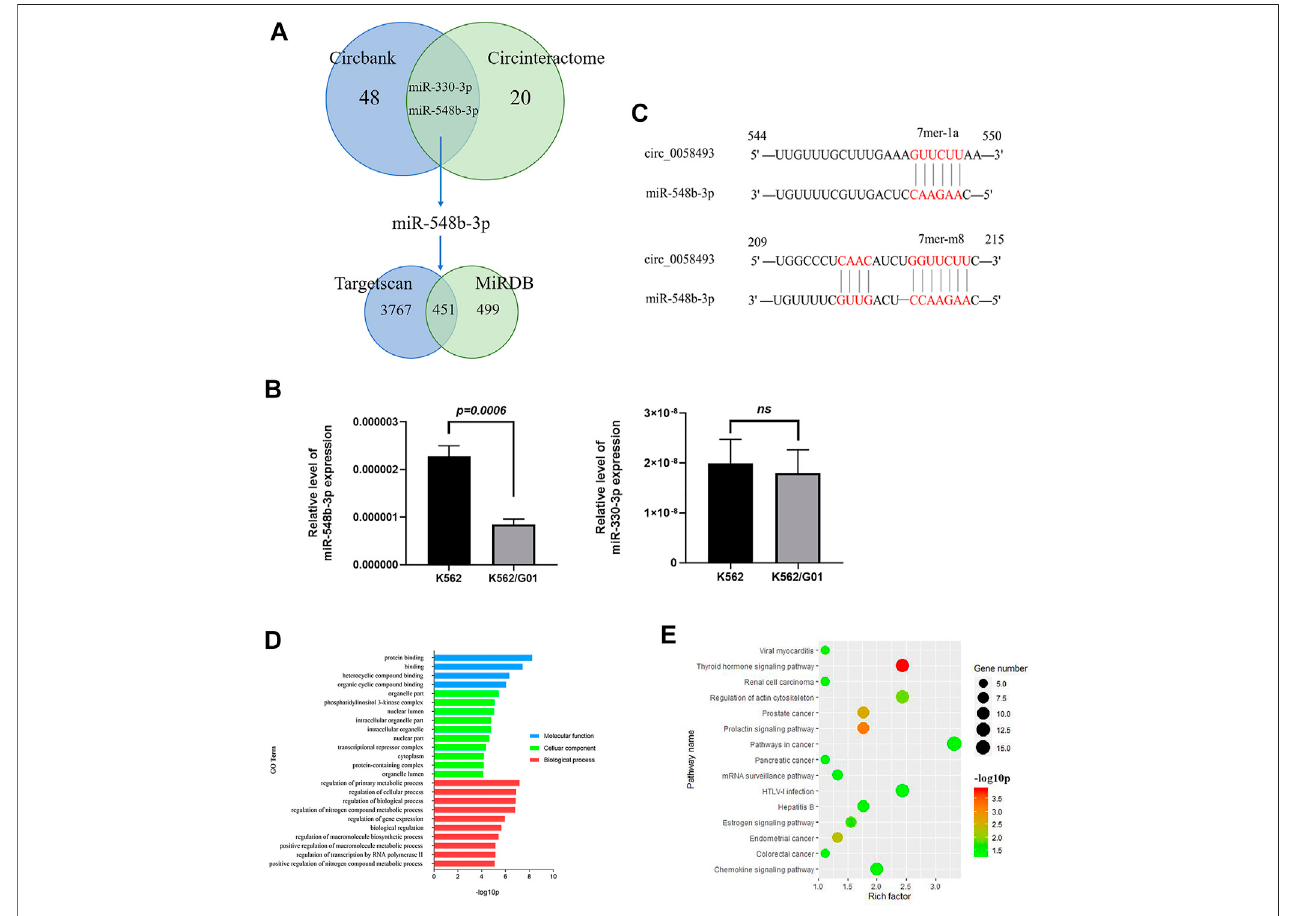
FIGURE4| Hsa_circ_0058493mayinvolveinseveralphysiologicalprocessesbyinteracting withmiR-548b-3p. (A) Bioinformatics predictionofmiRNA andtarget mRNAassociatedwithhsa_circ_0058493. (B) Theexpression oftwopredictedmiRNAs (miR-548b-3p andmiR-330-3p)weredetectedinK562/G01 andK562viaRT- qPCR. The expression level of miR-548b-3p showed a signi fi cant difference ( p (cid:1) 0.0006). (C) There were two binding sites between miR-548b-3p and circ_0058493, which were located at 209-215 bp and 544-550 bp. (D) GO analysis of mRNA associated with hsa_circ_0058493/miR-548b-3p. (E) KEGG pathway analysis of mRNA associated with hsa_circ_0058493/miR-548b-3p. Quantitative data from three independent experiments are shown as the mean ± SD (error bars). ns: not statistically signi fi cant (Student ’ s t